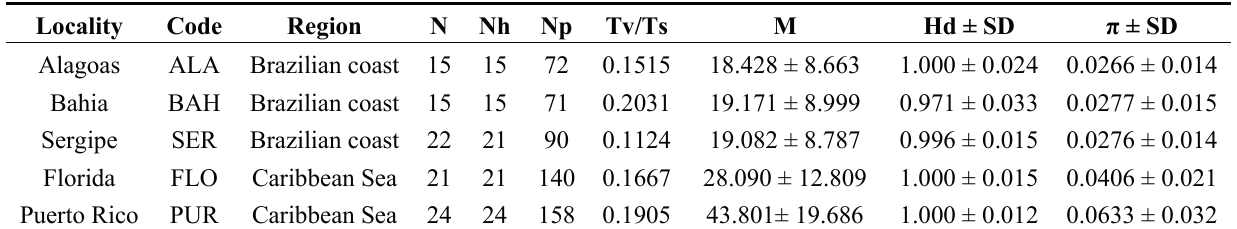
Table 1. Collection locations, sample size (N) and summary statistics of genetic variability for C. guanhumi populations along the Western Central Atlantic.